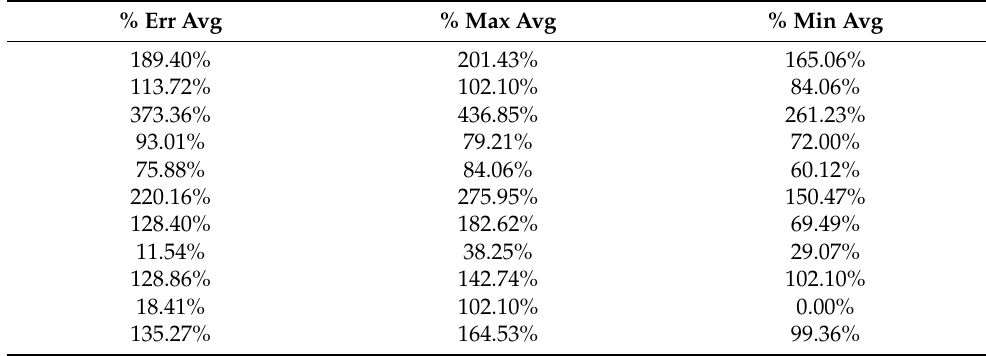
Table A227. Set 3, trials 41–50 data (all 0.5 PR